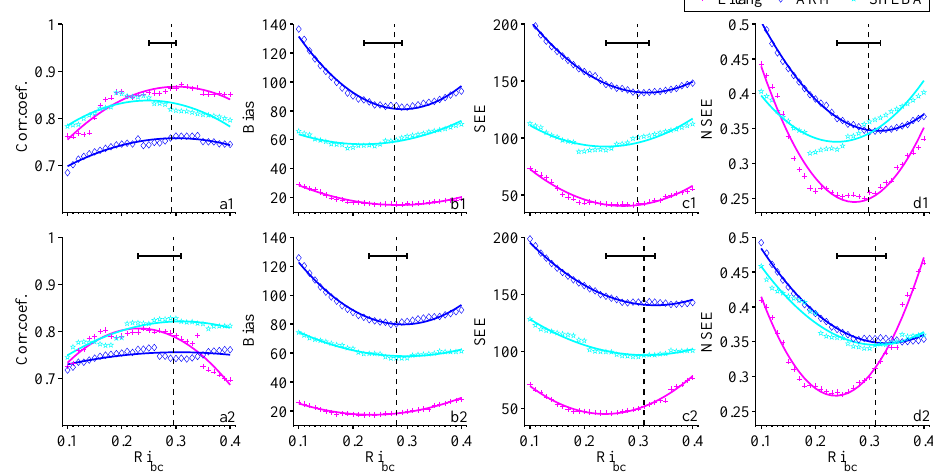
Figure 9. Comparison between estimated PBLHs using the bulk Richardson number method with z s = 40m (upper panels) and z s = 80m (lower panels) and observed PBLHs for type II SBLs. The correlation coefficient (a) , bias (b) , standard error (c) , and normalized standard error (d) are shown. The sounding data are taken from Litang (plus sign), ARM Shouxian (diamond), and SHEBA (pentacle). The curved lines are obtained by quadratic curve-fitting, the black vertical dashed lines indicate a representative Ri bc for all three sites, and the error bars indicate the range of Ri bc across the three